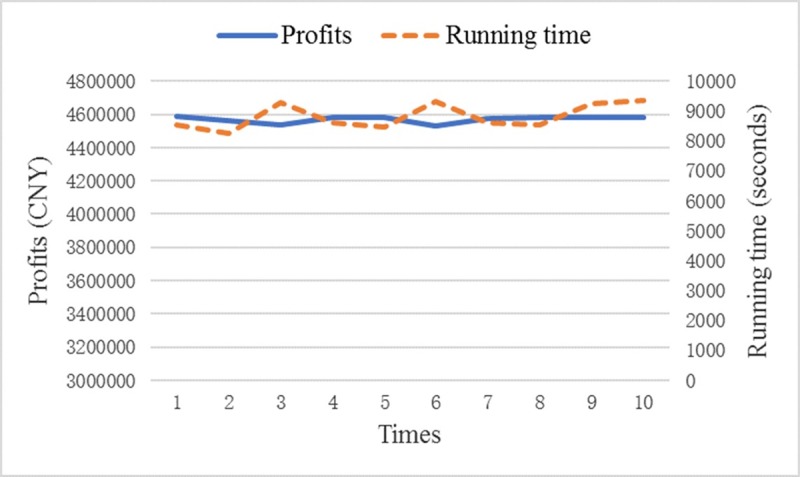
Results of CPSO.